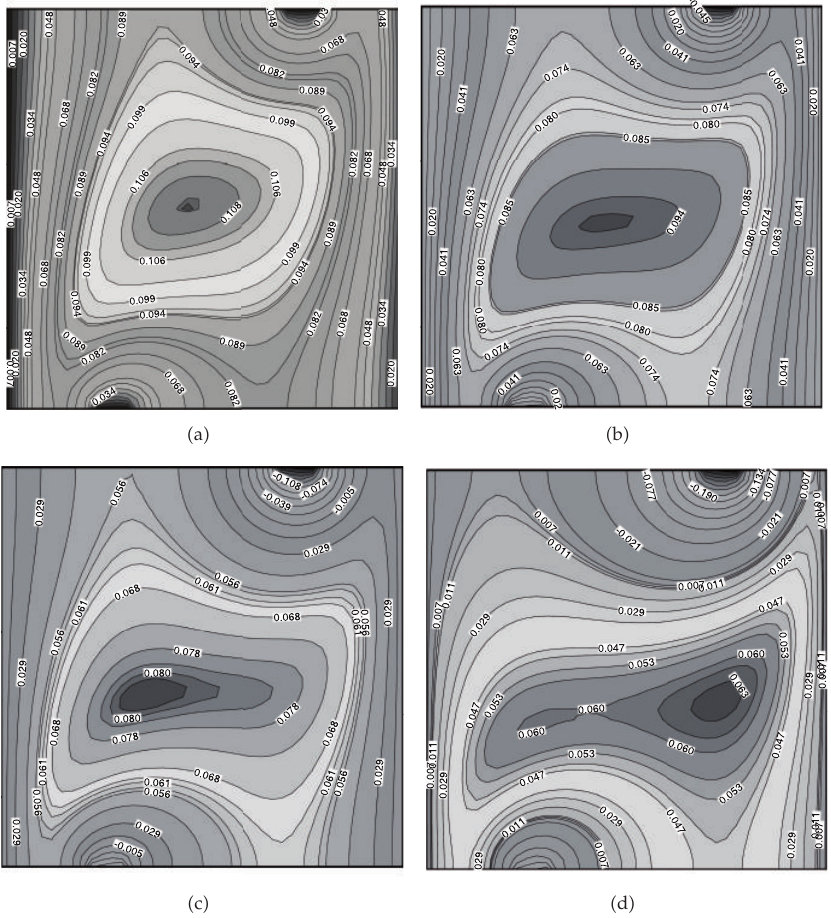
Figure 6: Streamline contours along the left vertical wall while fixing Le (cid:8) 1, B (cid:8) 1, (cid:2) D/H (cid:3) (cid:8) 0 . 1, Ra (cid:8) 100, S C (cid:8) 0 . 1 for (cid:2) a (cid:3) a (cid:8) 0 . 0, (cid:2) b (cid:3) a (cid:8) 0 . 1, (cid:2) c (cid:3) a (cid:8) 0 . 25, (cid:2) d (cid:3) a (cid:8) 0 .